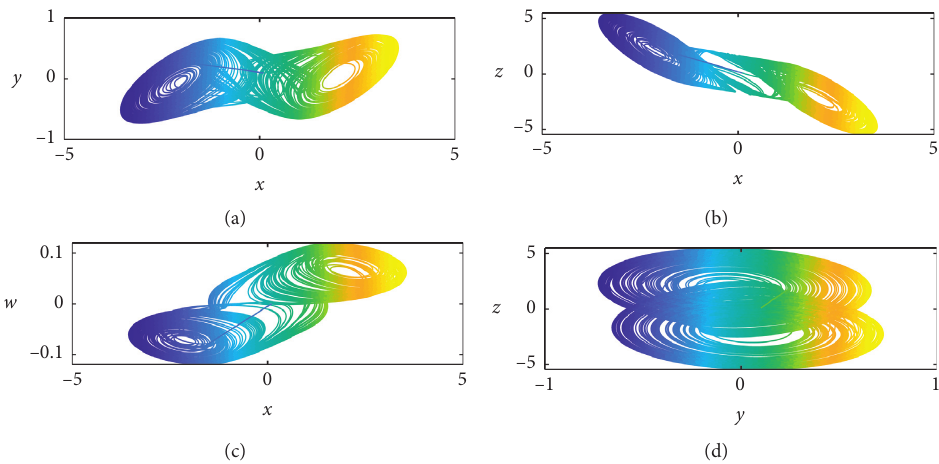
Figure 3: MATLAB simulation results of the modified Chua’s chaotic circuit: (a) in x − y plane, (b) in x − z plane, (c) in x − w plane, and (d) in y − z plane.